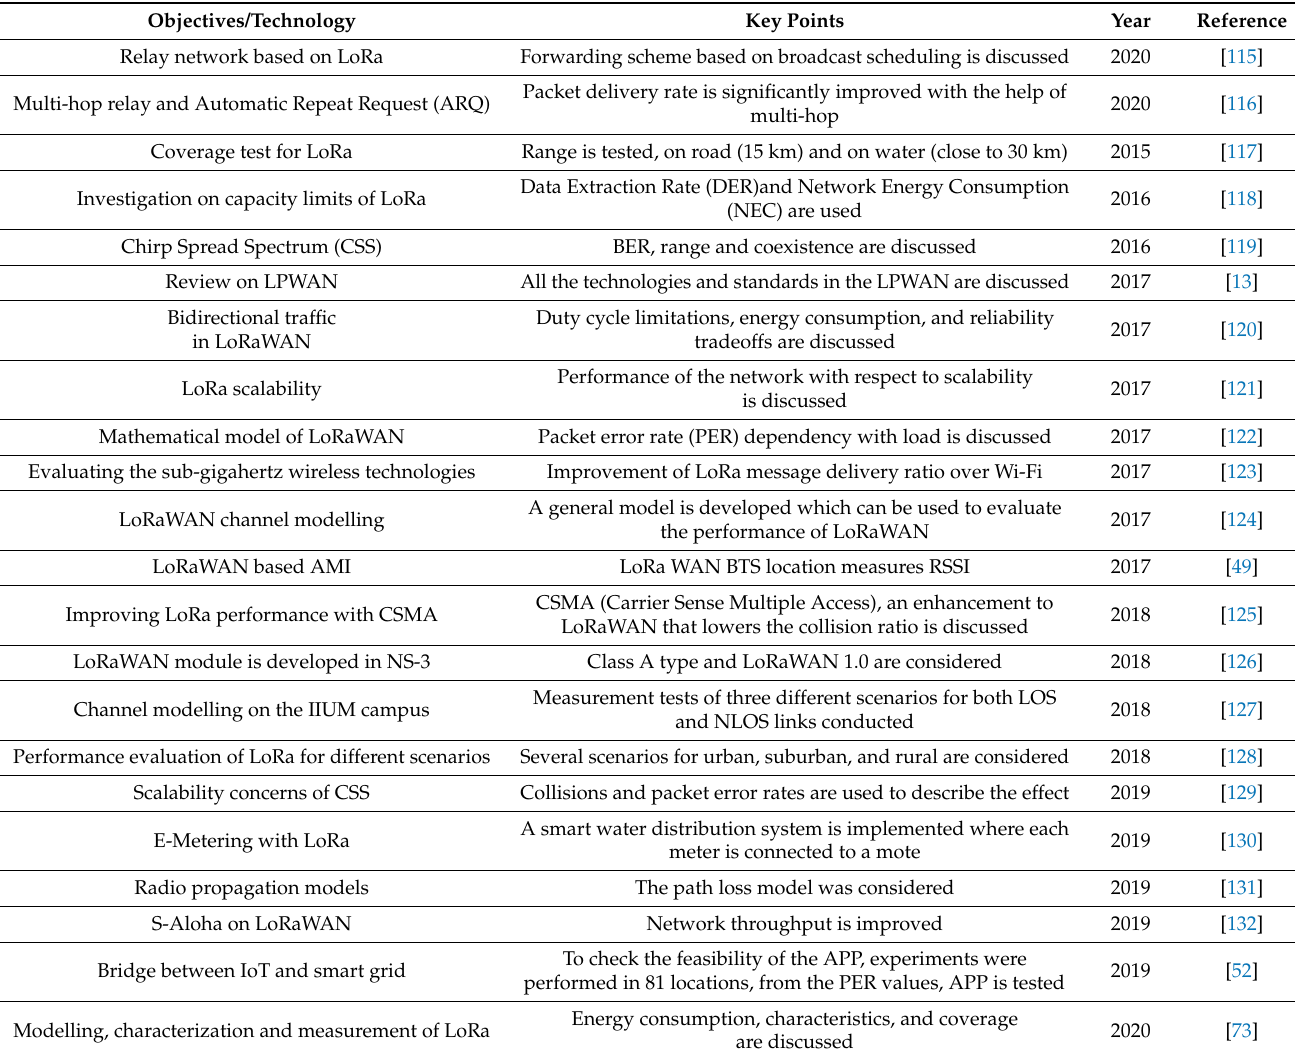
Table 11. Key works developed using LoRa